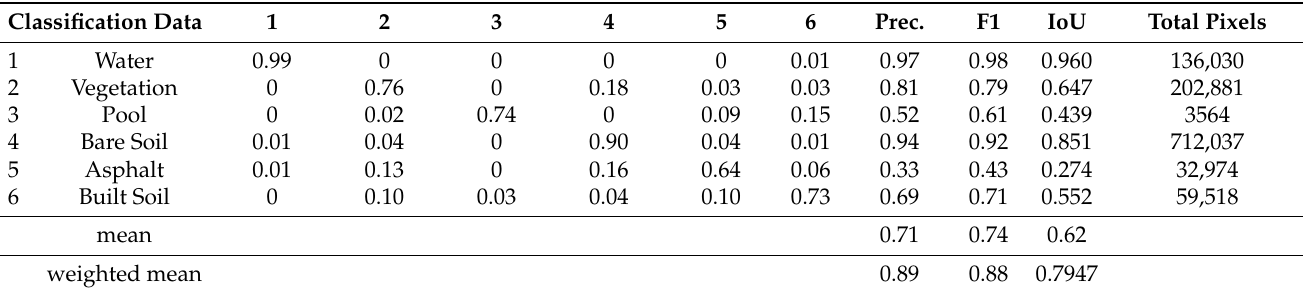
Table 3. Confusion matrix, precision, F1-score and IoU results obtained with the test set of the Maspalomas dataset.